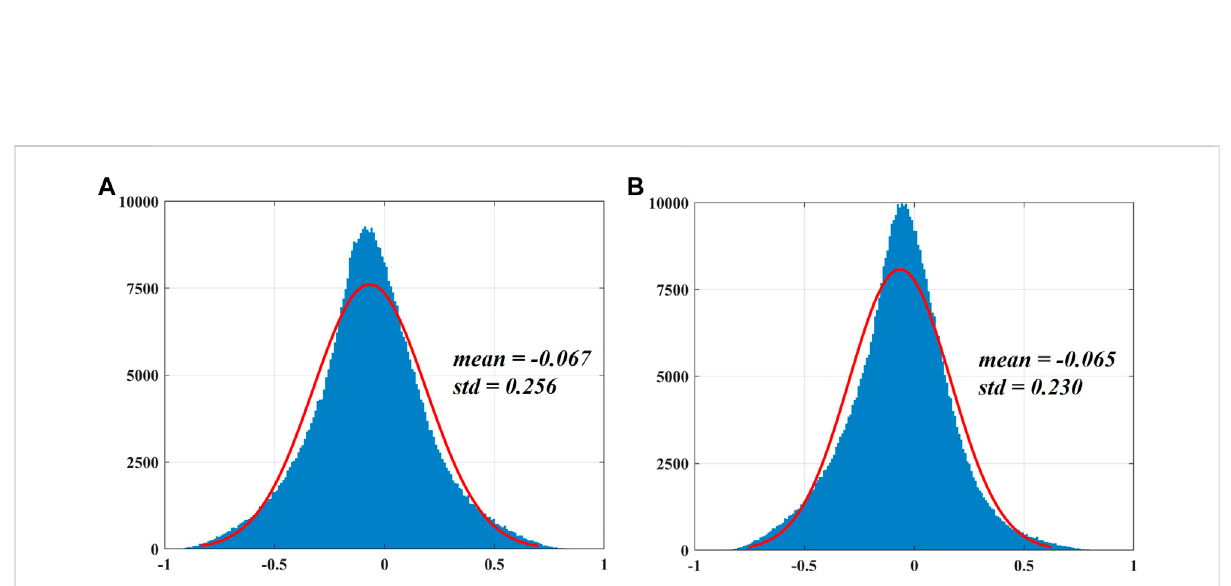
FIGURE 11 The error histogram of the validation area A (A) VV channel (B) VH channel.